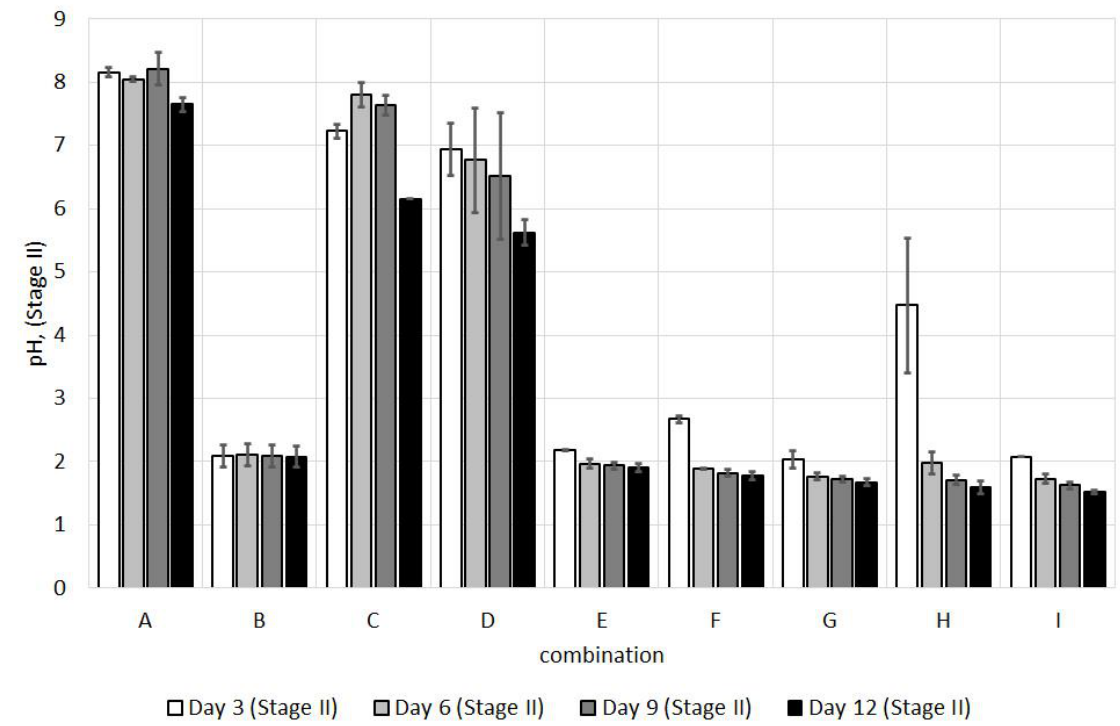
Figure 2. Changes in pH in the combinations tested in Stage II.